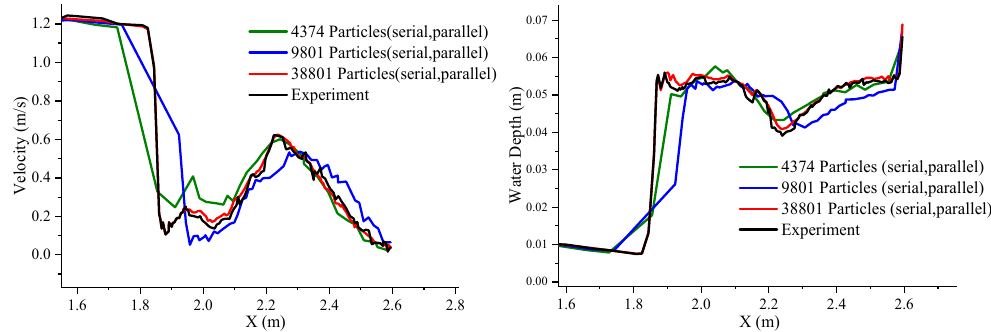
Figure 8. Numerical vs. experimental results comparison (velocities on the left and water depths on the right ).